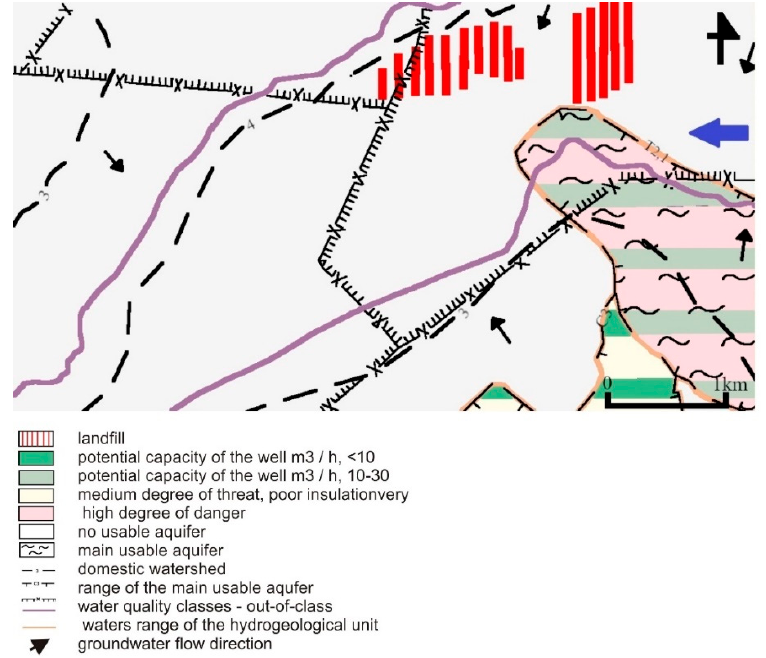
Figure 3. Hydrogeological map of the study area [34].